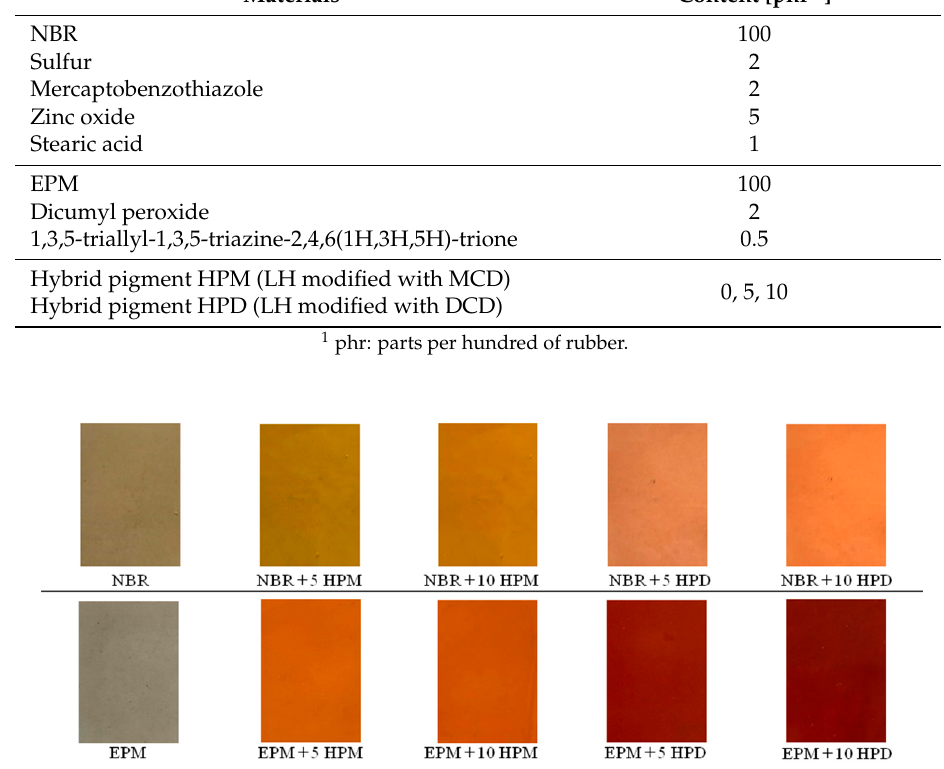
Figure 3. Digital photos of NBR and EPM composites containing hybrid pigments.